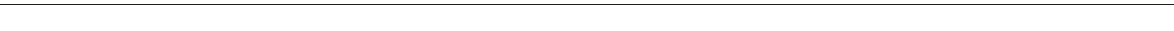
Fig. 4 PP2A-B55 α holoenzymes interact with SAMHD1 in cycling cells. a SAMHD1 interacts with PP2A-B55 α holoenzymes. HEK293T cells were co- transfected with constructs expressing N-terminally FLAG-tagged SAMHD1 (3.5 µ g) and different N-terminally GST-tagged PP2A B-type subunits (7.5 µ g). 48 h post-transfection, cells were harvested, lysed and CoIPs performed using anti-GST-coated magnetic beads. Proteins were analyzed by immunoblotting using antibodies speci fi c to the indicated proteins. Data shown are representative of three independent experiments. b Reciprocal CoIP experiment. HEK293T cells were co-transfected with constructs expressing N-terminally FLAG-tagged SAMHD1 (5.5 µ g) and GFP-tagged PP2A B55 α subunit (5.5 µ g). Sole transfection of the expression plasmid encoding GFP-tagged PP2A B55 α subunit was used as a negative control. 48h post-transfection, cells were harvested, lysed and CoIPs performed using anti-FLAG-coated agarose beads. Proteins were analyzed by immunoblotting using antibodies speci fi c to the indicated proteins. Data shown are representative of three independent experiments. c SAMHD1 interacts with endogenous PP2A B55 α subunit in HEK293T cells. Cells were transfected with constructs expressing N-terminally FLAG-tagged SAMHD1 or empty vector as a negative control. 48h post-transfection, cells were harvested, lysed and CoIPs performed using anti-FLAG-coated agarose beads. Proteins were analyzed by immunoblotting using antibodies speci fi c to the indicated proteins. Data shown are representative of two independent experiments. d Endogenously expressed SAMHD1 interacts with endogenous PP2A B55 α subunit in monocytic THP-1 cells. Cycling THP-1 cells were harvested (2×10 7 cells/sample), lysed and CoIPs performed using anti-IgG1/SAMHD1-coated sepharose beads. Proteins were analyzed by immunoblotting using antibodies speci fi c to the indicated proteins. Data shown are representative of two independent experiments. e Comparison of basic amino acids in the C-terminal region of human (Hs) and murine (isoform 1; Mm) SAMHD1. Alignment of SAMHD1 protein sequences was generated with ClustalW. Basic residues are highlighted in black, while non-basic residues at the corresponding positions are highlighted in gray. Introduction of non- basic residues into human SAMHD1 (Hs ∙ Mm) and, vice versa, basic residues into murine SAMHD1 (Mm ∙ Hs) are marked in red. f SAMHD1 interacts with PP2A-B55 α holoenzymes through basic amino acids. HEK293T cells were transfected with constructs expressing N-terminally FLAG-tagged human/murine (isoform 1) SAMHD1 or mutants with substituted/introduced basic residues. Empty vector was transfected as a negative control. 48h post-transfection, cells were harvested, lysed and CoIPs performed using anti-FLAG-coated agarose beads. Proteins were analyzed by immunoblotting using antibodies speci fi c to the indicated proteins. Data shown are representative of three independent